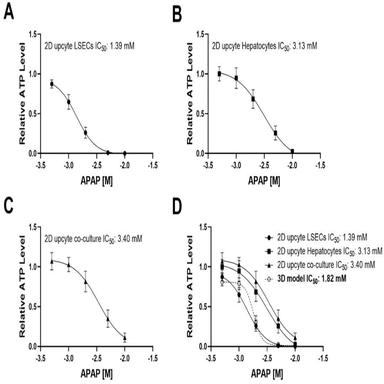
Comparison of cellular viability in 2D monocultures, co-culture and Dynamic42 3D model after APAP administration. (A-C) Relative ATP levels in 2D cultured upcyte® LSECs from donor 462 (A), upcyte® hepatocytes from donor 732–03 (B) and co-culture (C). (D) Comparison of relative ATP levels in 2D cultures and 3D model. Cellular viability was determined after 7 days of treatment with control (10% PBS) or 0.5, 1, 2, 5, 10 mM APAP. Relative luminescence units (RLU) are plotted as relative ATP levels of control-tr